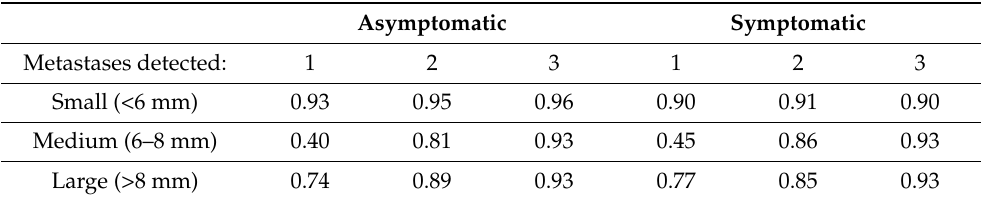
Table A17. Proportion of oligo+ within patients with detected oligo-metastases in the Metastatic metastases 80%